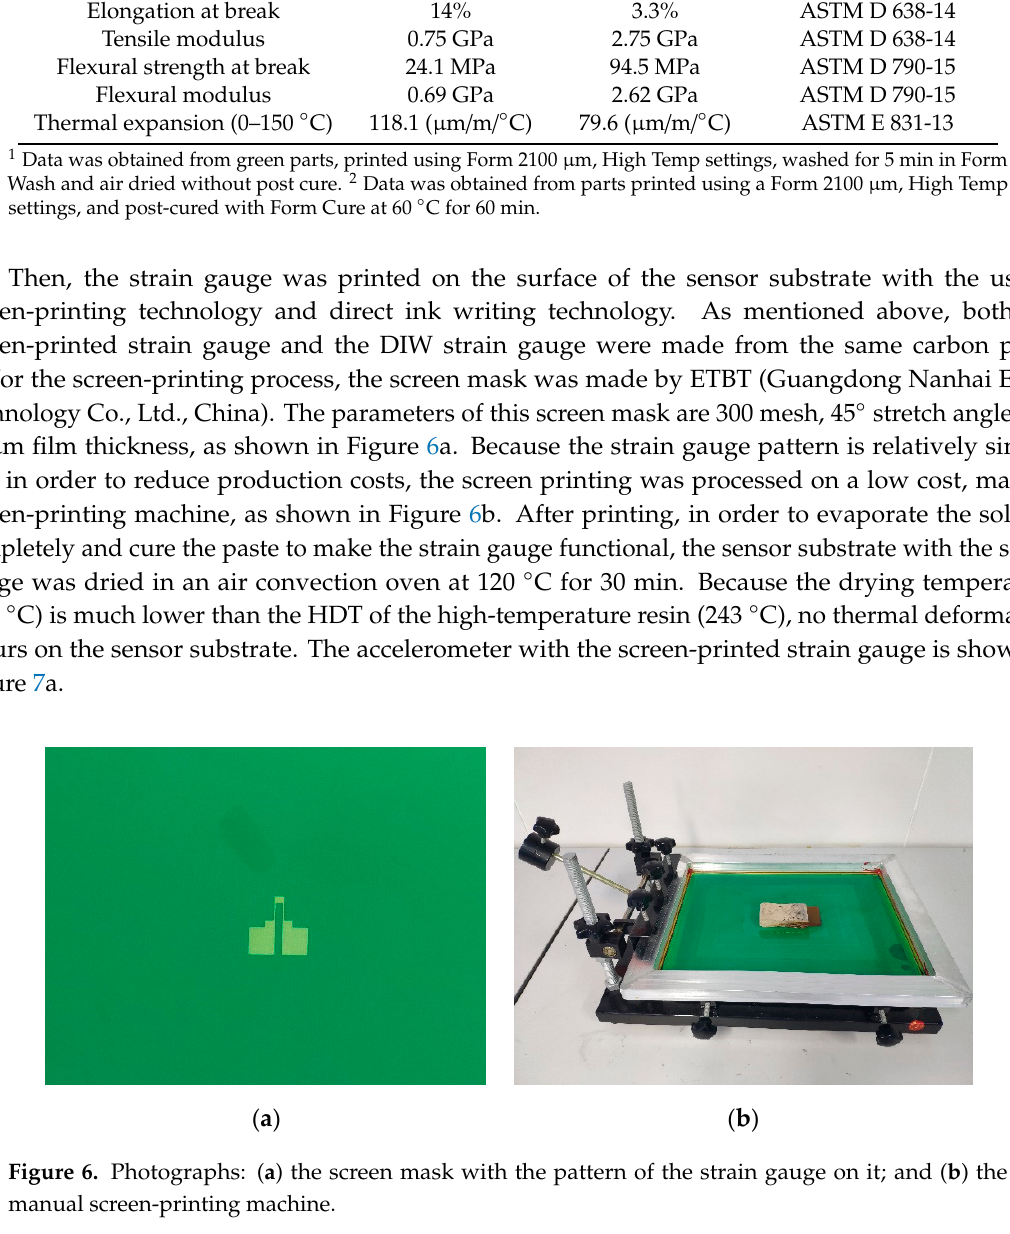
Table 1. Properties of the high-temperature resin.